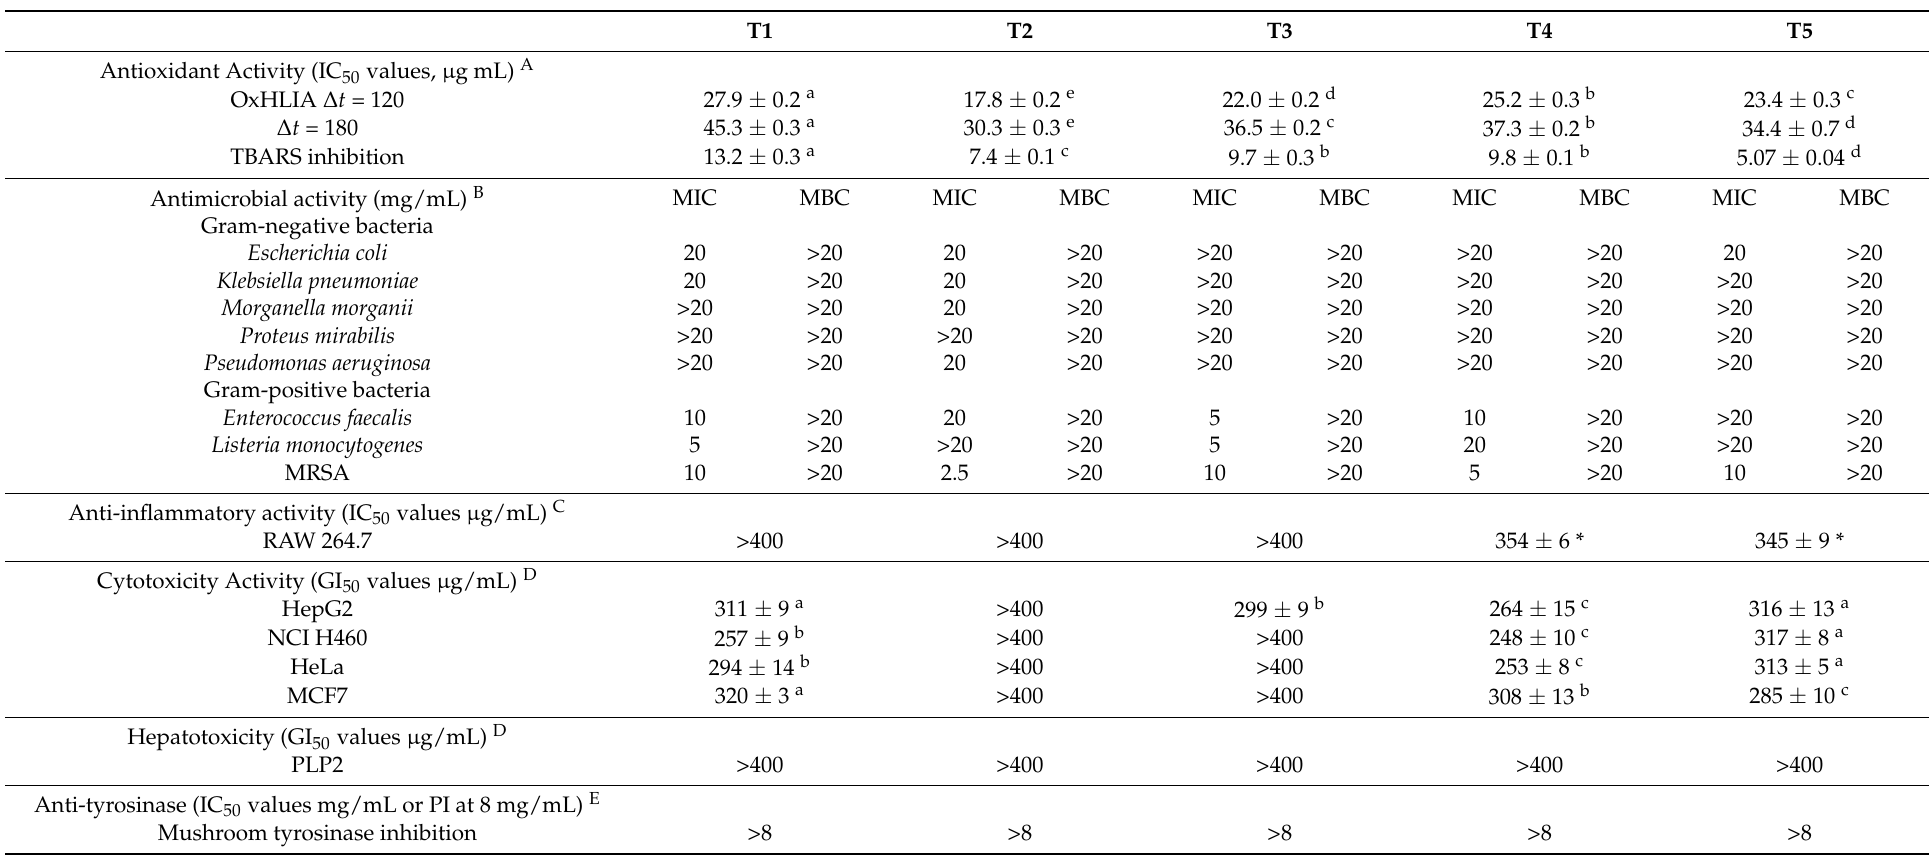
Table 5. Bioactive properties of the five tisanes prepared from five MAP mixtures (mean ± SD).